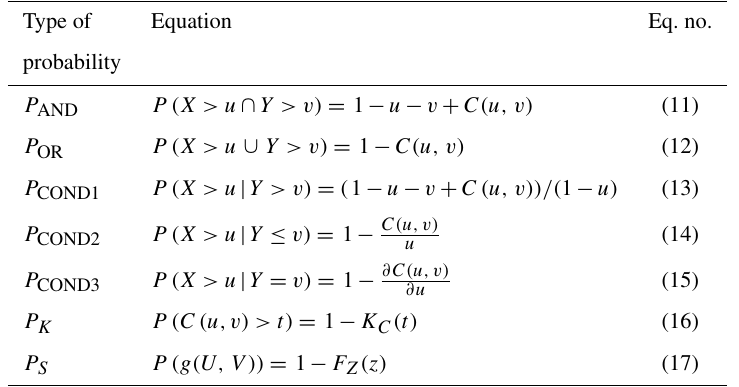
Table 1. Types of probabilities for bivariate ( X, Y ) return period estimation. u and v are extreme thresholds. From Serinaldi (2015). Type of Equation Eq. no.